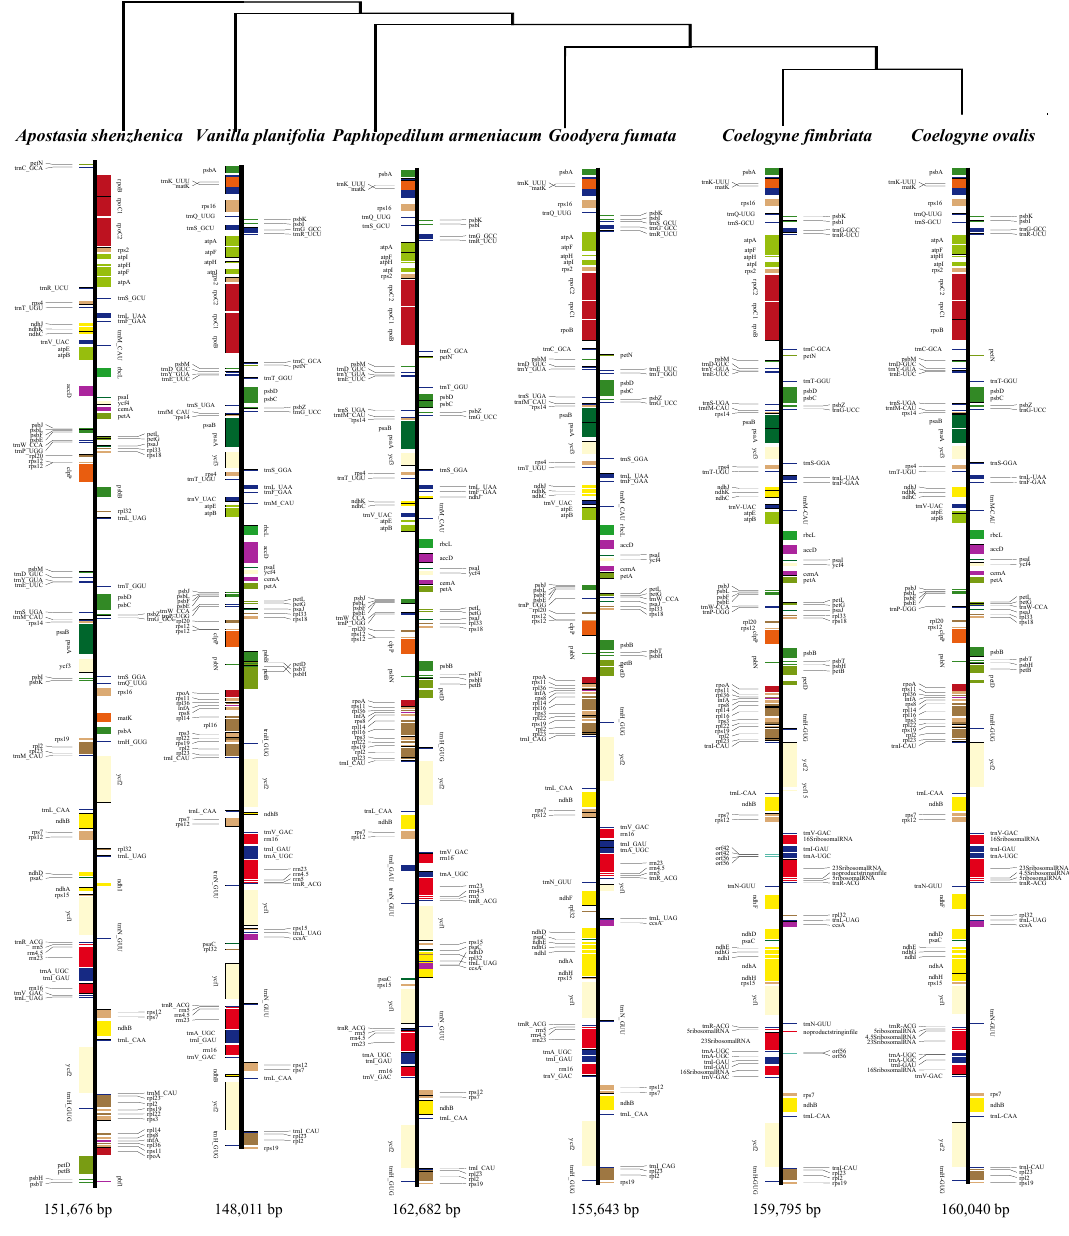
Figure 3. Comparative chloroplast genomes of six Orchidaceae species representing Apostasioideae ( Apostasia shenzhenica ), Vanilloideae ( Vanilla planifolia ), Cypridoideae ( Paphiopedilum armeniacum ), Orchidoideae ( Goodyera fumata ), and Epidendroideae ( Coelogyne